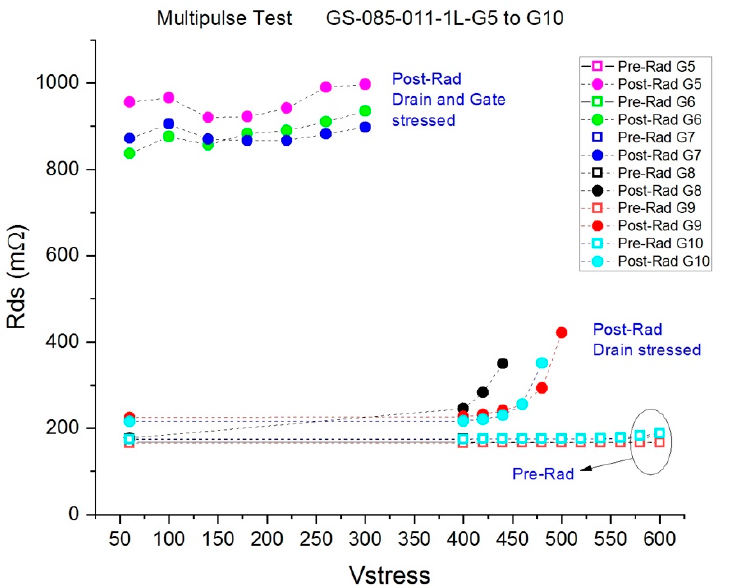
Figure 12. The results of the multi-pulse test for the R ON values of devices G5–G10, which were irradiated at 53 °C.